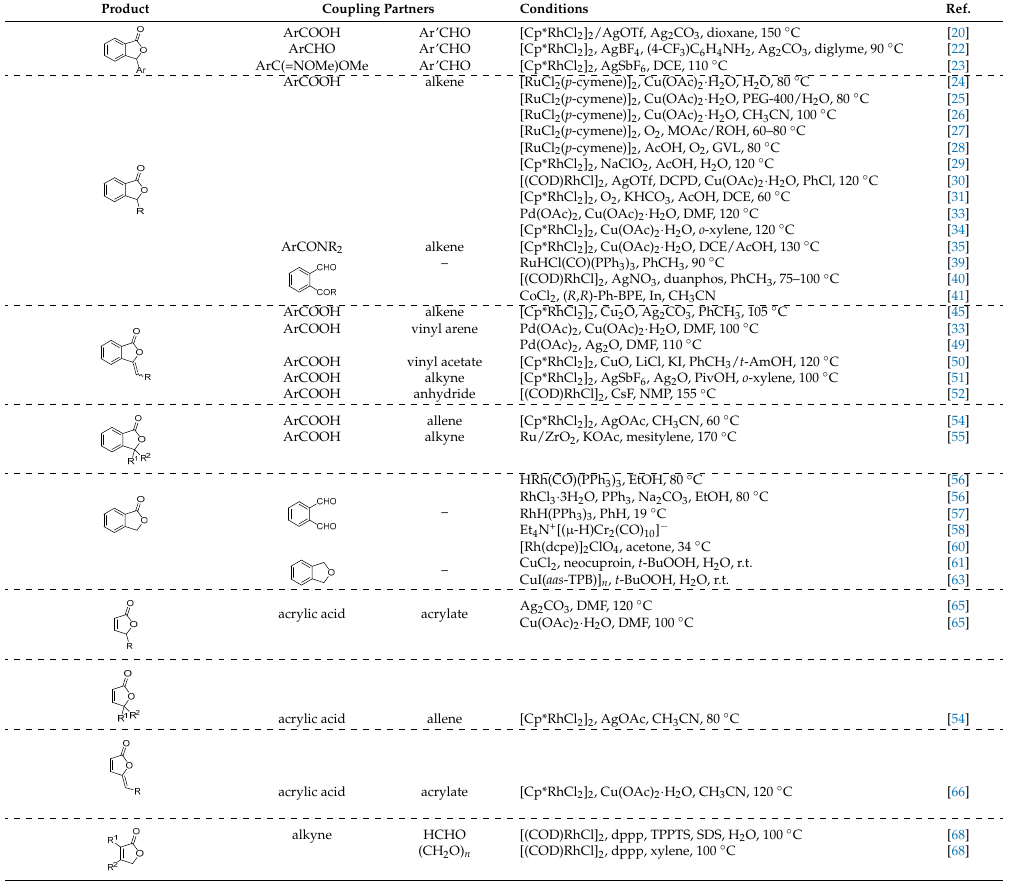
Table 2. Summary of preparation methods of phthalides and α , β -butenolides.